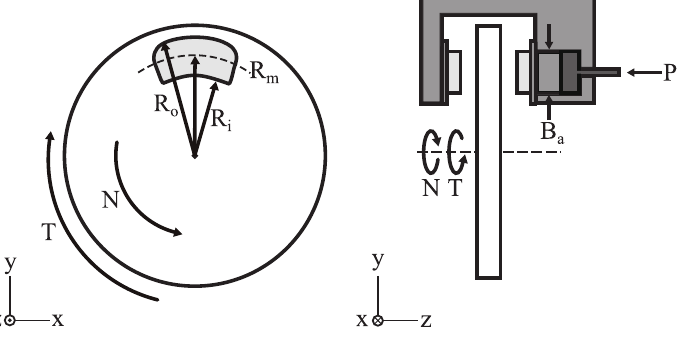
Figure 3. Forces acting on the rotor and caliper.